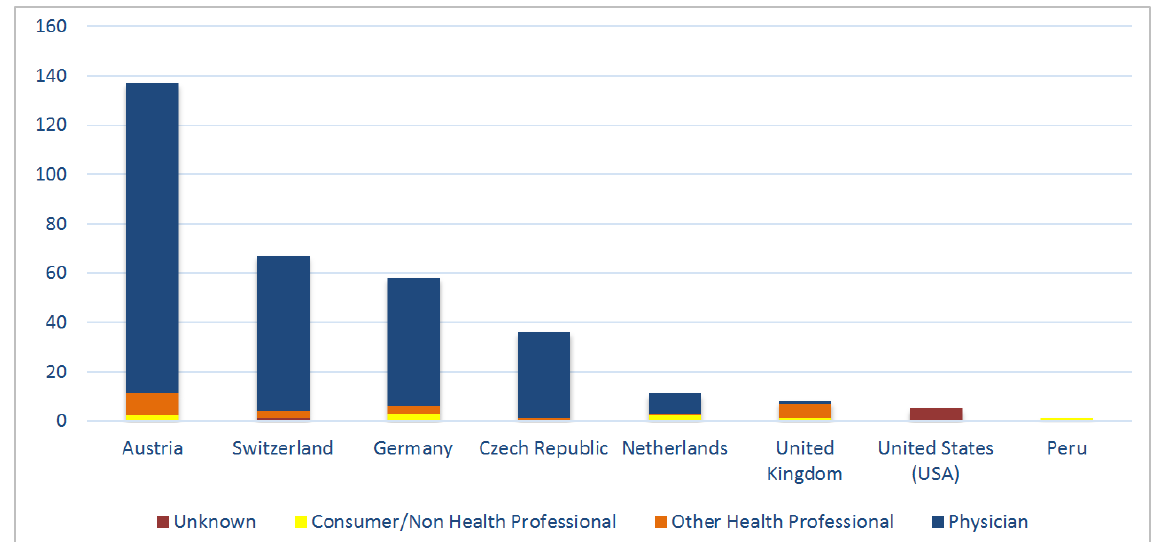
Figure 2: Number of individual safety reports stratified by country of origin and reporters’